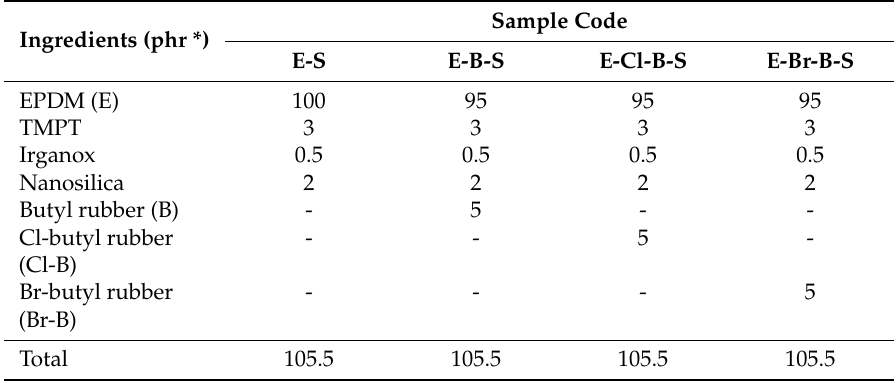
Formulation of the Ethylene–propylene–diene terpolymer (EPDM) / butyl(halobutyl) rubber / nanosilica